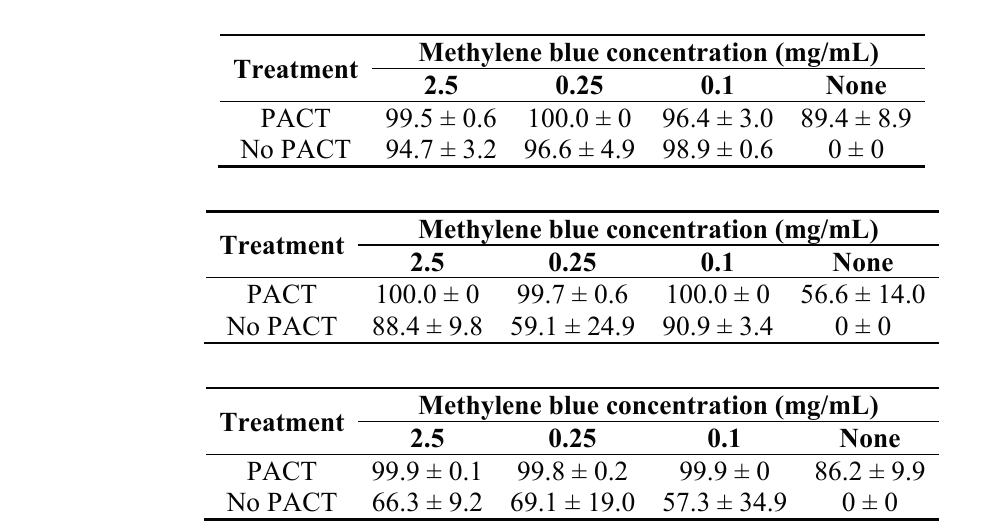
Table 2. Percentage kill of the strains ( A ) S. aureus , ( B ) E. coli and ( C ) C. albicans (Means ± S.D., n = 4).